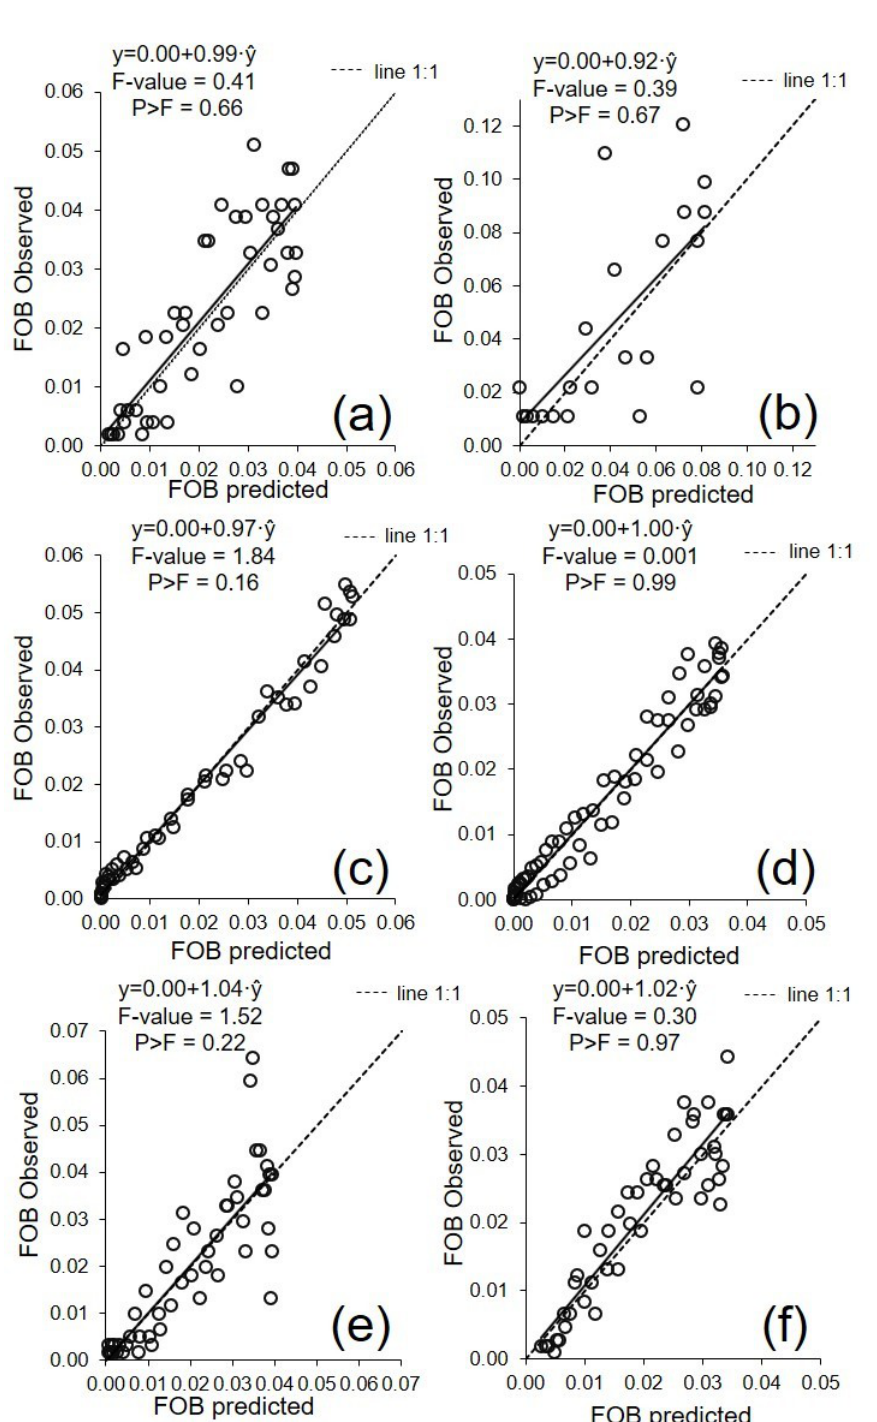
Figure 3. Predicted against observed fire occurrence by biomass level (FOB) for the regions CHAP ( a ); N ( b ); NW and NE( c ); C (d); SC ( e ) and SE ( f ). F -values and probabilities ( p > F ) correspond to the simultaneous F -test for intercept = 0 and slope = 1. Dotted lines represent the 1:1 line and full lines represent the observed (y) against predicted (ŷ) FOB linear regression lines.